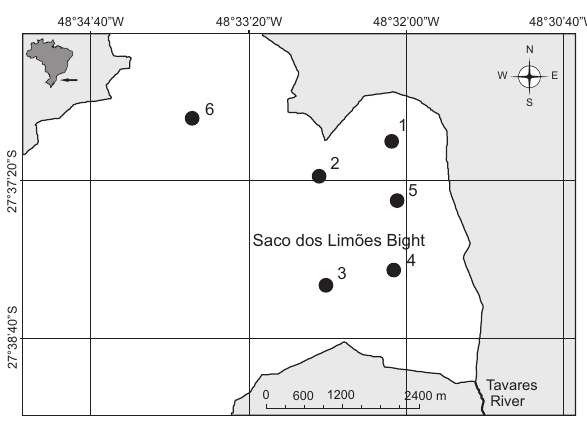
Figure 1. Study area and localization of sampling stations at Saco dos Limões bight, southern